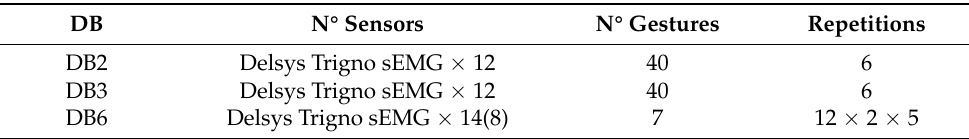
Table 1. NinaPro Data. Data employed in this study come from DB2, DB3, DB6 NinaPro datasets. The 8 electrode-array was used for the